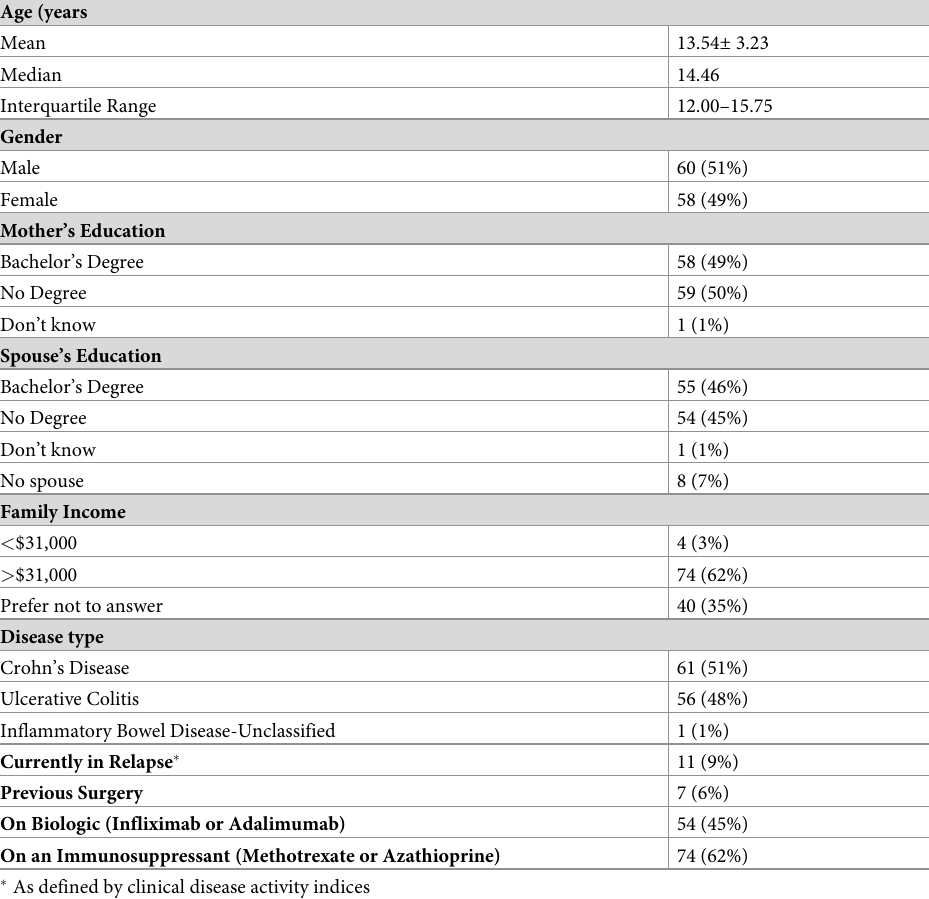
Table 1. Demographic characteristics of participants. � As defined by clinical disease activity